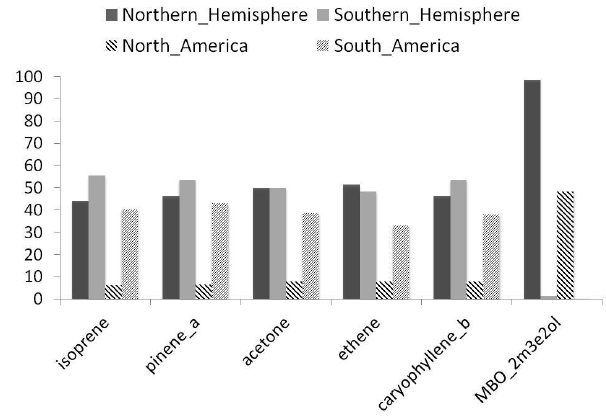
Figure 4: Regional contributions to global total emissions of selected compounds. Fig. 4. Regional contributions to global total emissions of selected